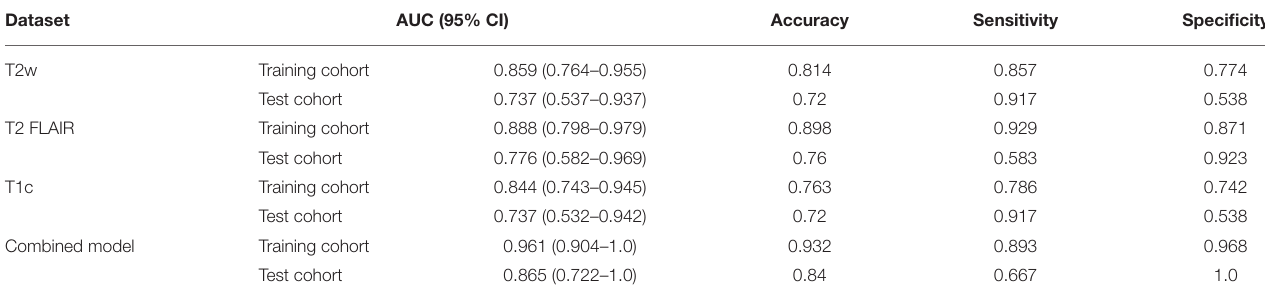
TABLE 4 | Comparison of the diagnostic efficiency between the four models.